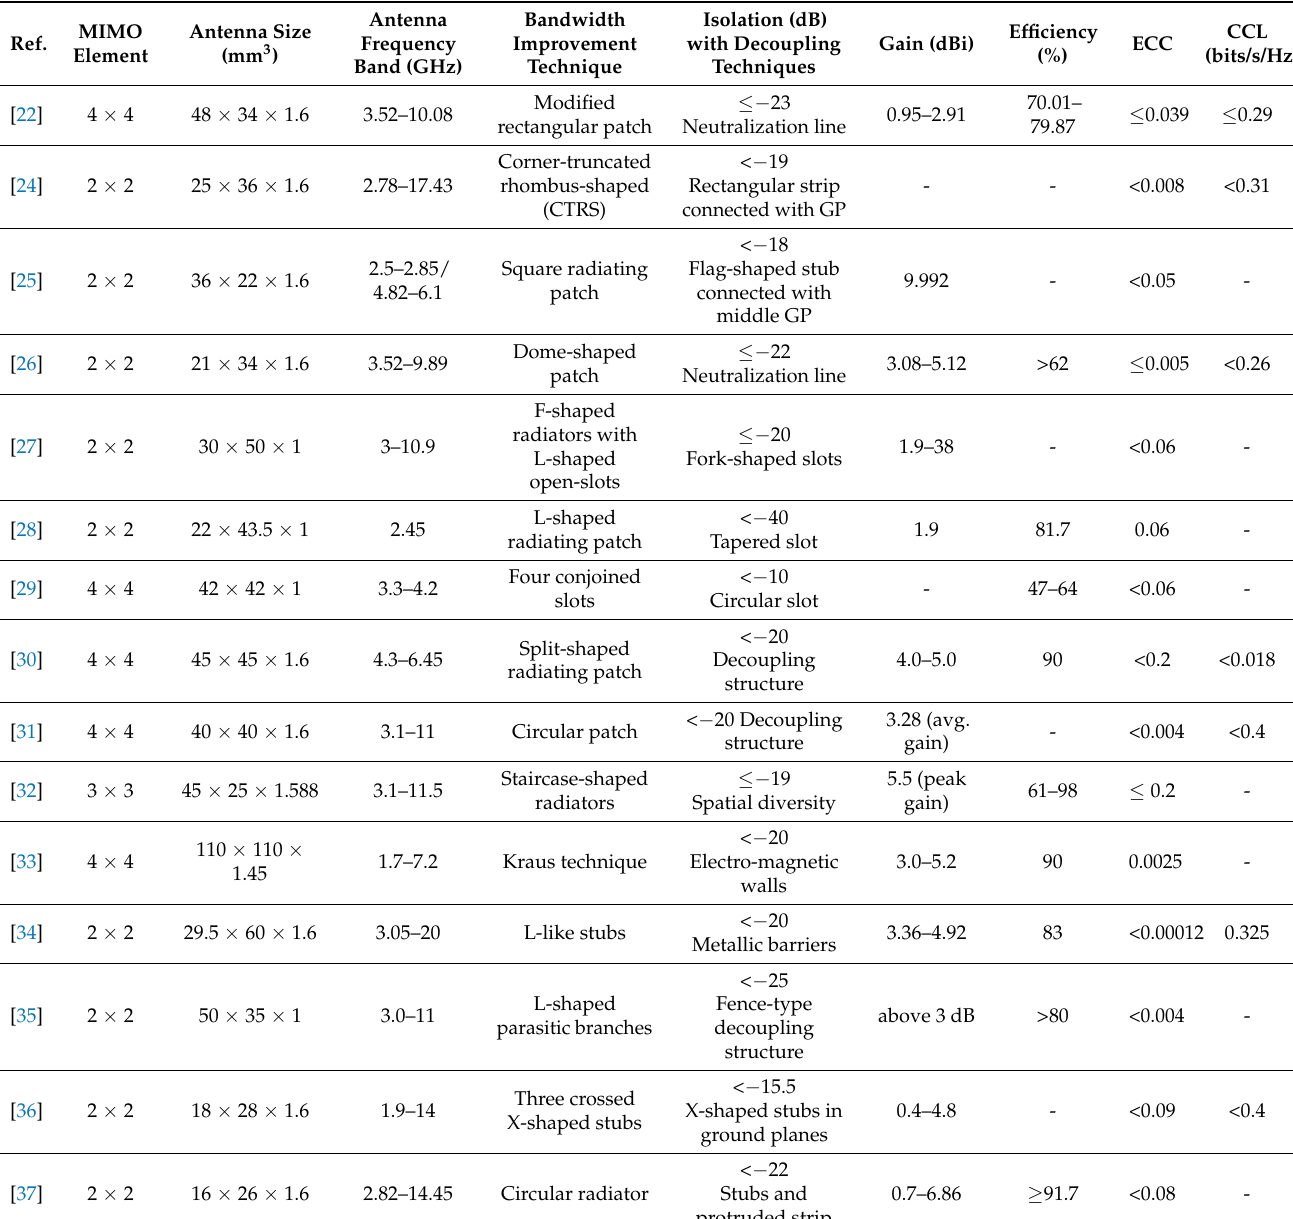
Table 1. Comparison of different UWB MIMO